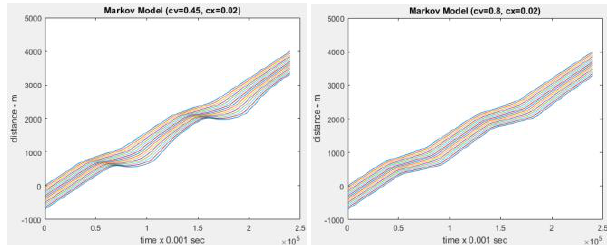
Fig. 21. The impact of the initial conditions on the